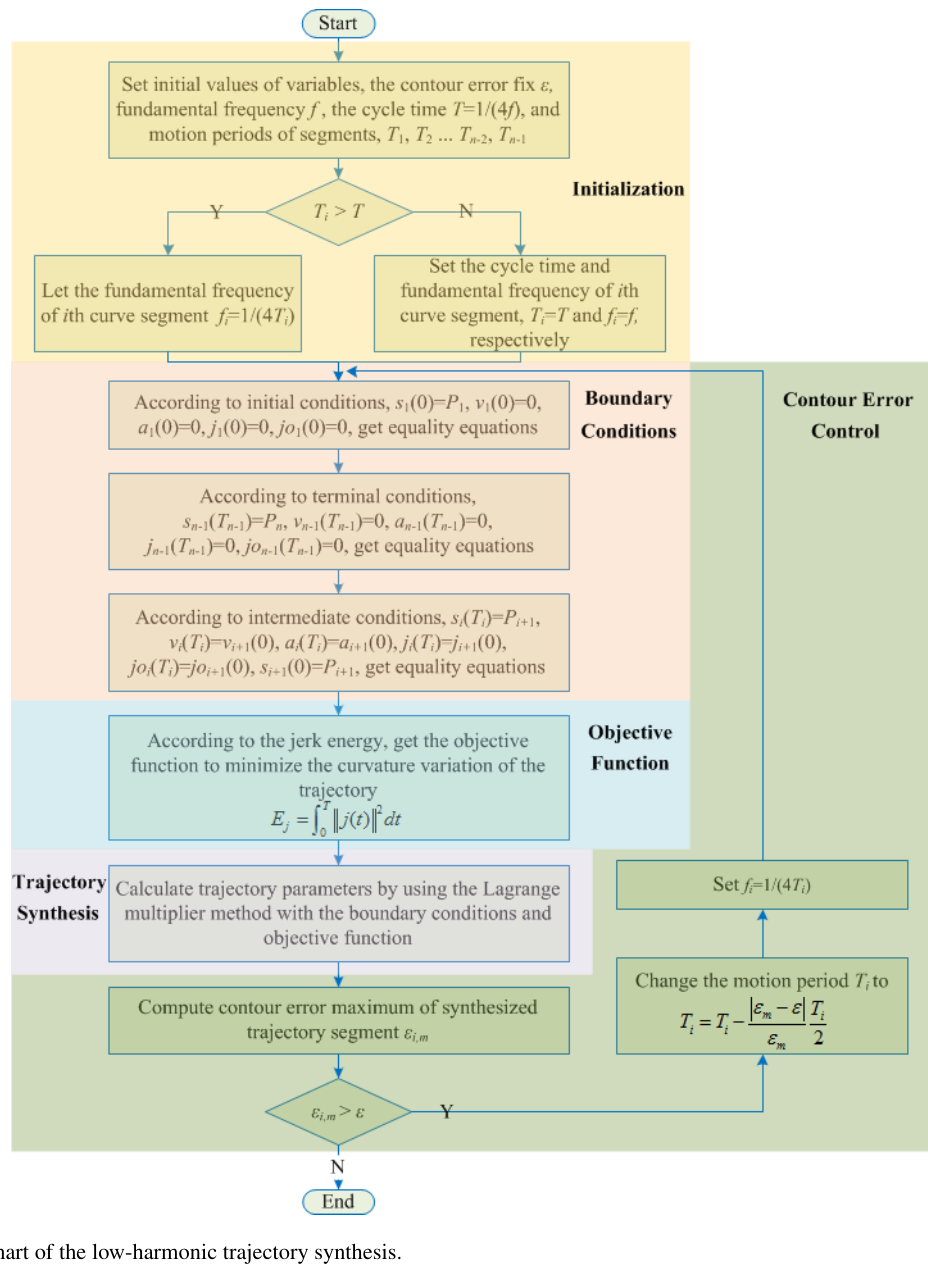
Figure 1. Flowchart of the low-harmonic trajectory synthesis.